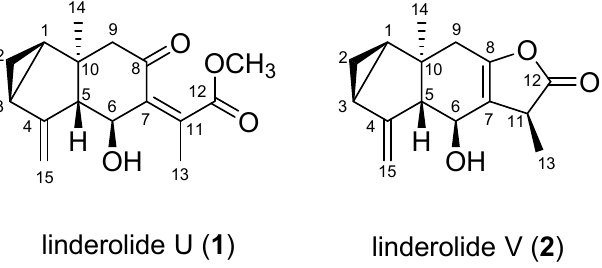
Figure 4. Chemical structures of isolated compounds 1 and 2 .